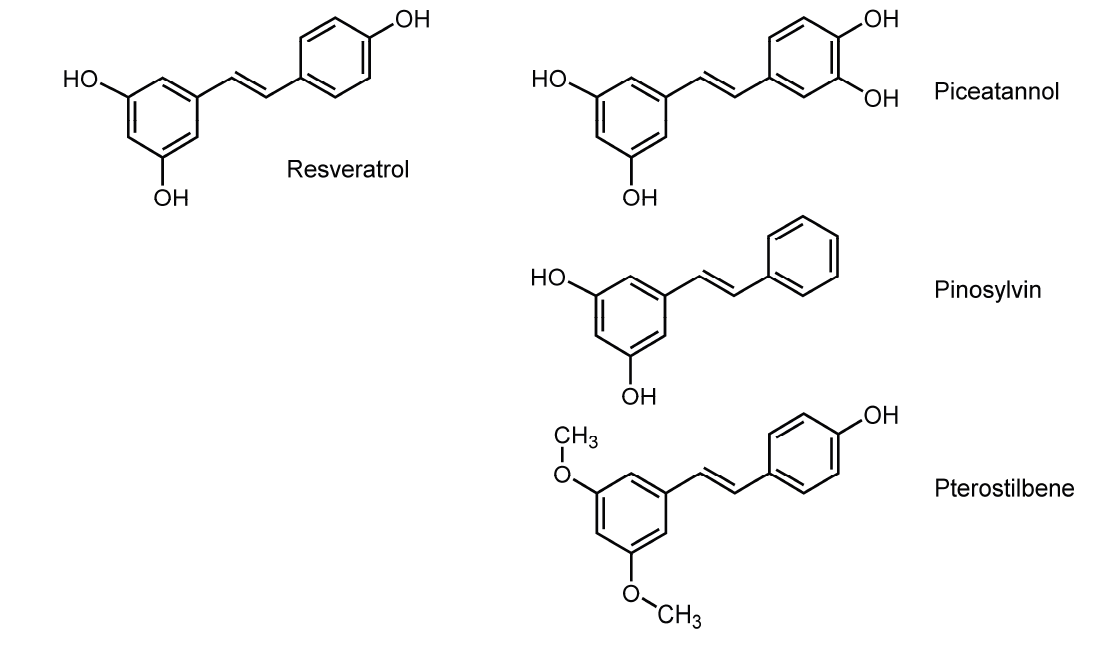
Figure 3. Structures of membrane-interactive